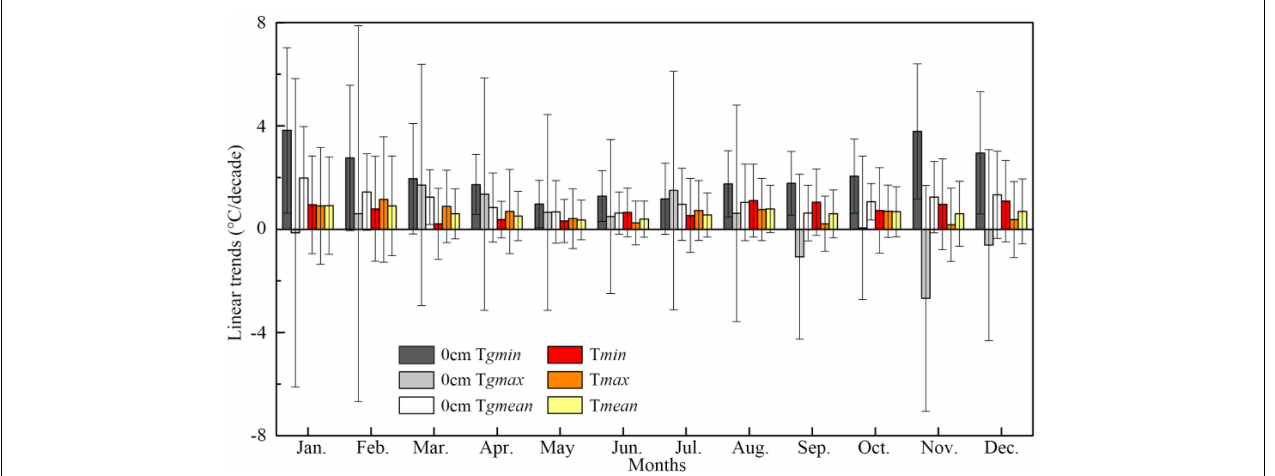
FIGURE 1 | Linear trends and standard errors of temperature in each month from 1989 to 2018 in Henan Station. The horizontal axis is the month in a year, and the vertical axis is the slope of the linear trend. The black/gray/white and red/orange/yellow bars represent minimum/maximum/mean daily 0 cm ground temperature (T gmin , T gmax , and T gmean ) and minimum/maximum/mean air temperature (T min , T max , and T mean ), respectively. Details of the statistics of the linear trends could be found in Supplementary Table 2 .